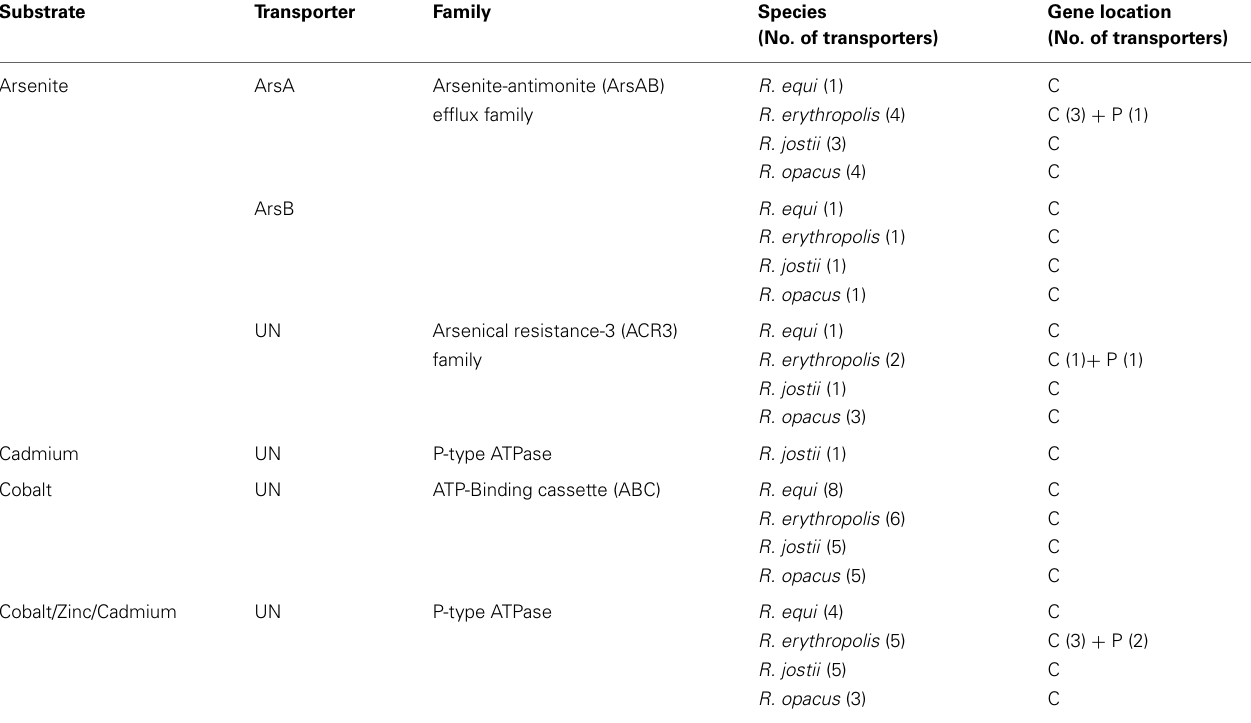
Table 3 | List of putative specific transporters for heavy-metals present in representative rhodococcal species.